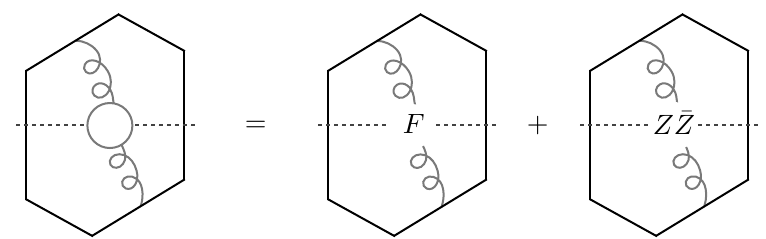
Figure 6 . The OPE cut of the two loop contribution to the bosonic Wilson loop reveals a pair of matter (cid:12)elds, coming from the bubble correction to the Chern-Simons propagator. Its twist-1 component can take the form of a gluonic (cid:13)ux tube excitation F or of a spinon-anti-spinon pair Z (cid:22) Z . They both start contributing at order O ( g 2 ) at weak coupling, according to our pentagon